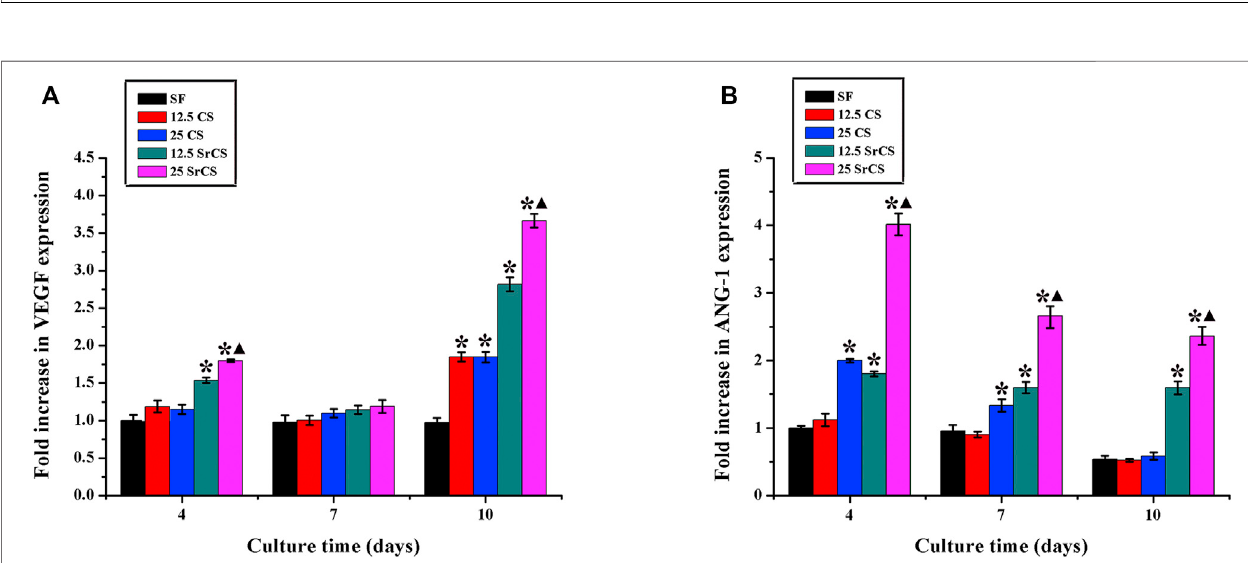
FIGURE 6 | Angiogenic gene expression analysis. The angiogenic gene expression of rBMSCs seeded on different materials (SF: SF, 12.5 CS: 12.5 wt% CS/SF, 25CS:25 wt%CS/SF,12.5SrCS:12.5 wt%SrCS/SF,25SrCS:25 wt%SrCS/SF)for4,7,and10 days. (A) VEGF; (B) ANG-1.TheSFgroupwastreatedasthecontrol group. * p < 0.05 indicates the other groups vs. the SF group, and ▲ p < 0.05 indicates the 25 SrCS group vs. the other